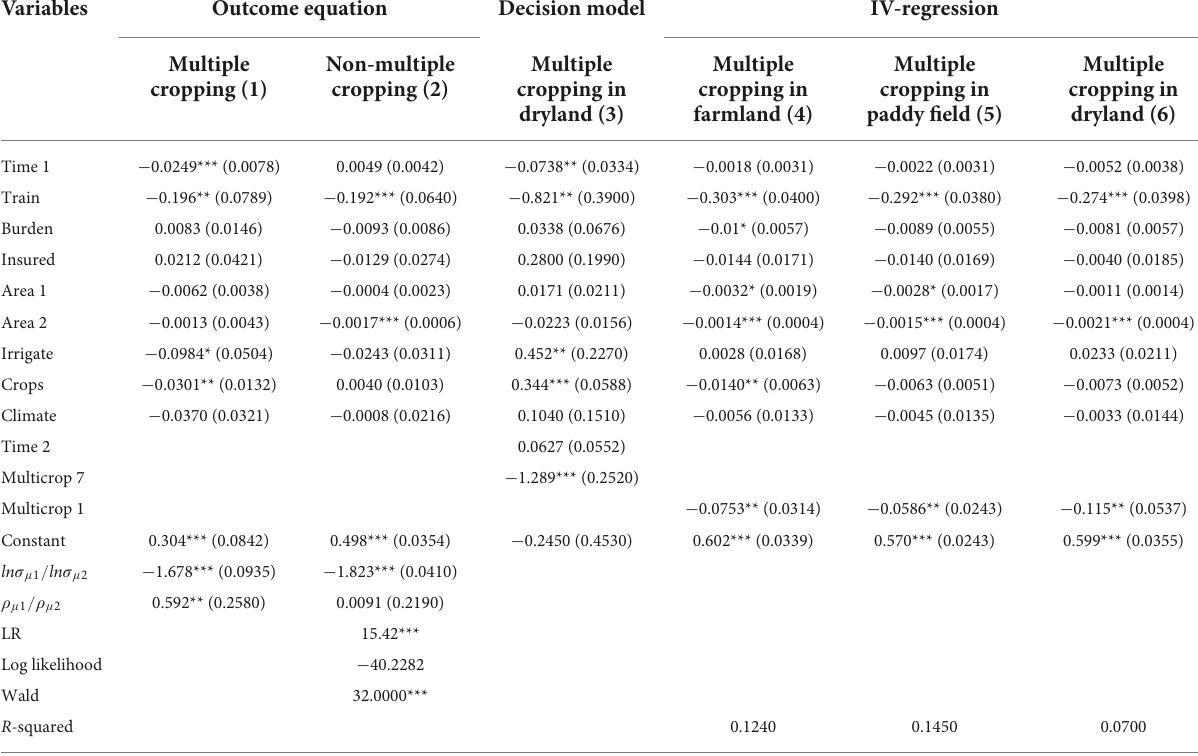
TABLE 3 Endogenous conversion model estimation results of dryland multiple cropping and the regression results of instrumental